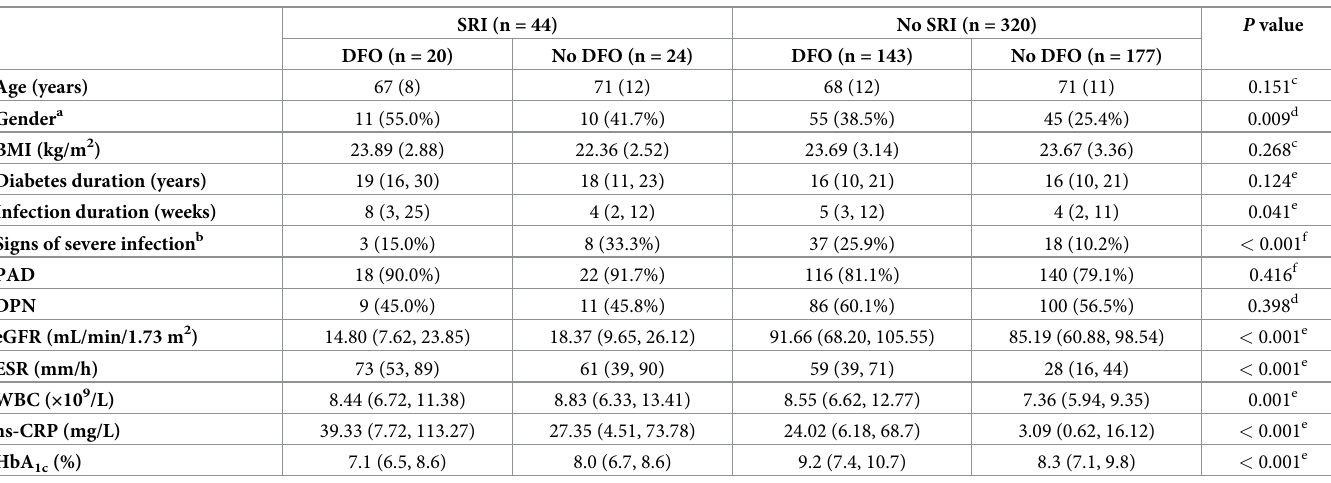
Table 1. Characteristics of patients with DFI.